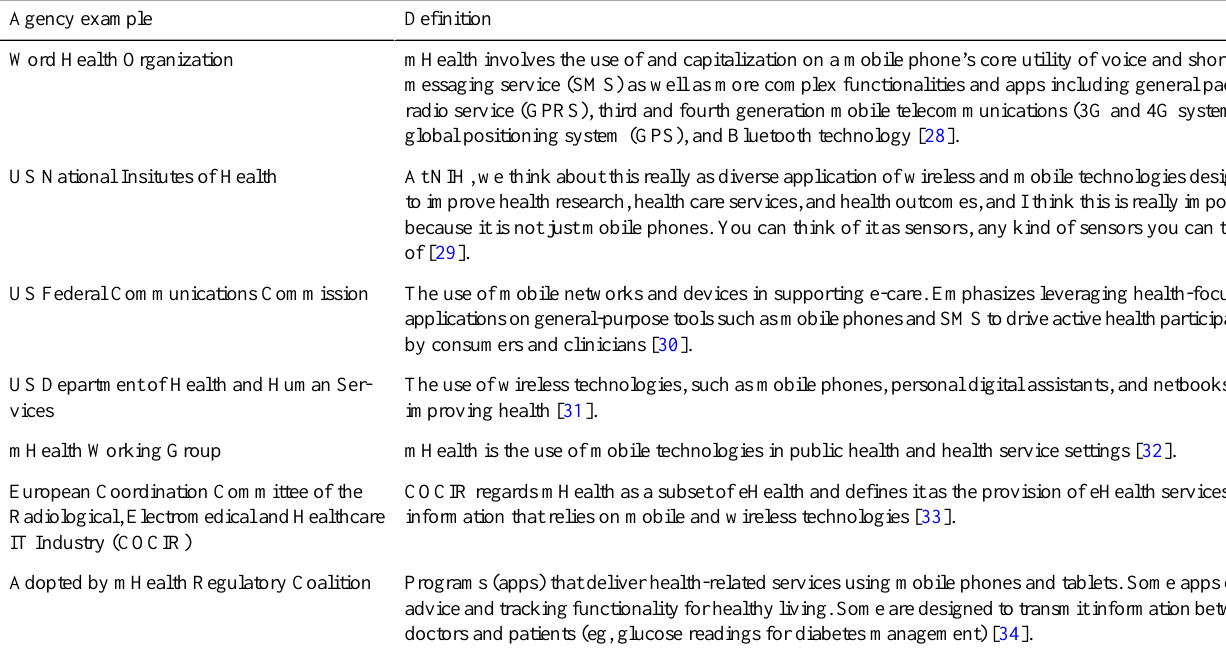
Table 1. Definitions of mHealth (mobile